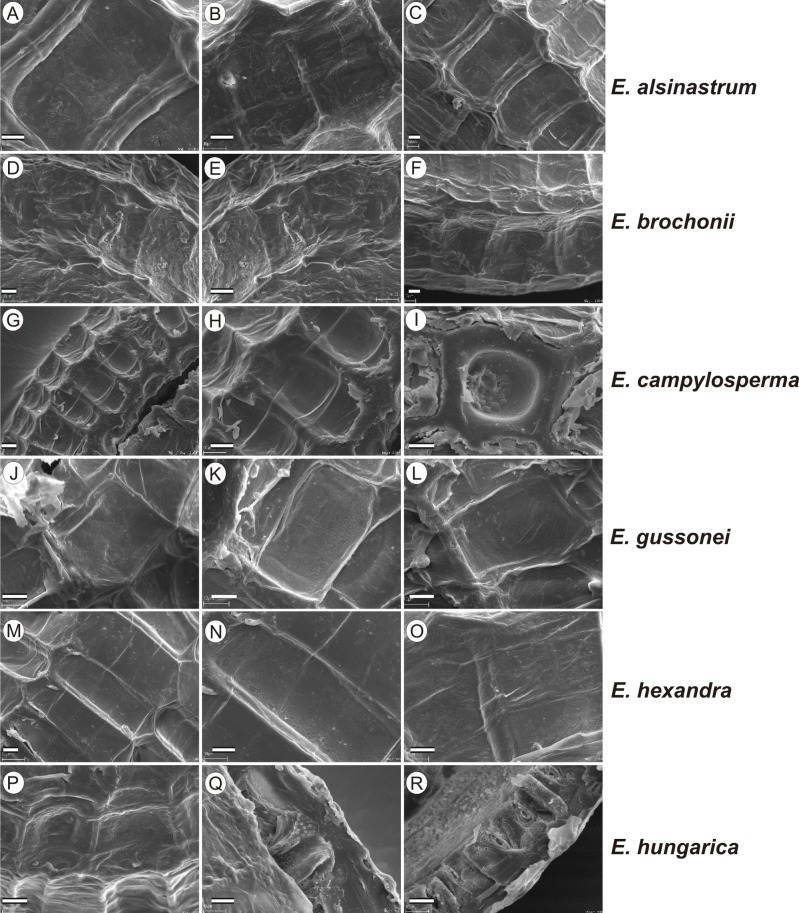
The diversity in seed coat micromorphology of Elatine alsinastrum (a–alsHu; b, c–alsPL1), E. brochonii (a, b–broMO; c–broSP), E. campylosperma (a, b–camIT; c–camSP), E. gussonei (a, b–gusMAL; c–gusSP), E. hexandra (a, b–hexPL1; c–hexPL2), E. hungarica (a, b–hunR; c–hunSL).Scale bar = 10 µm. For acronyms, see Table 1. (A–C) E. alsinastrum; (D–F) E. brochonii; (G–I) E. campylosperma; (J–L) E. gussonei; (M–O) E. hexandra; (P–R) E. hungarica.